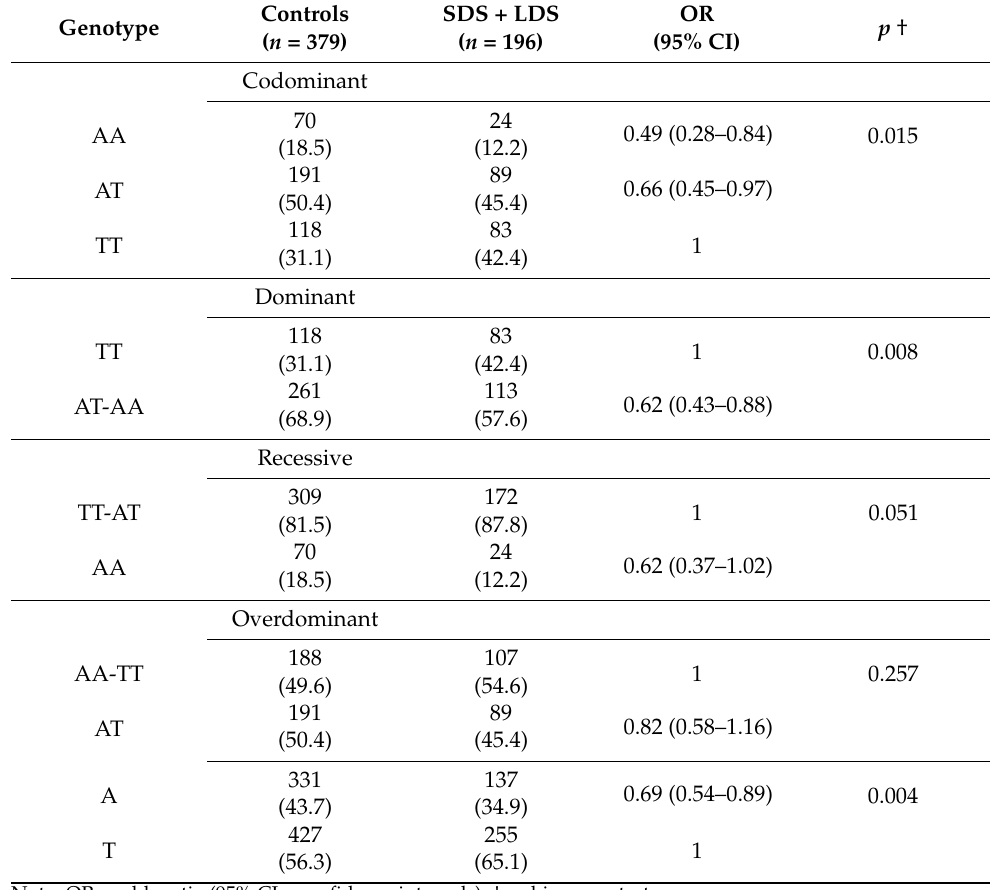
Table 1. Comparison of swimmers and control individuals (genotypes and alleles).